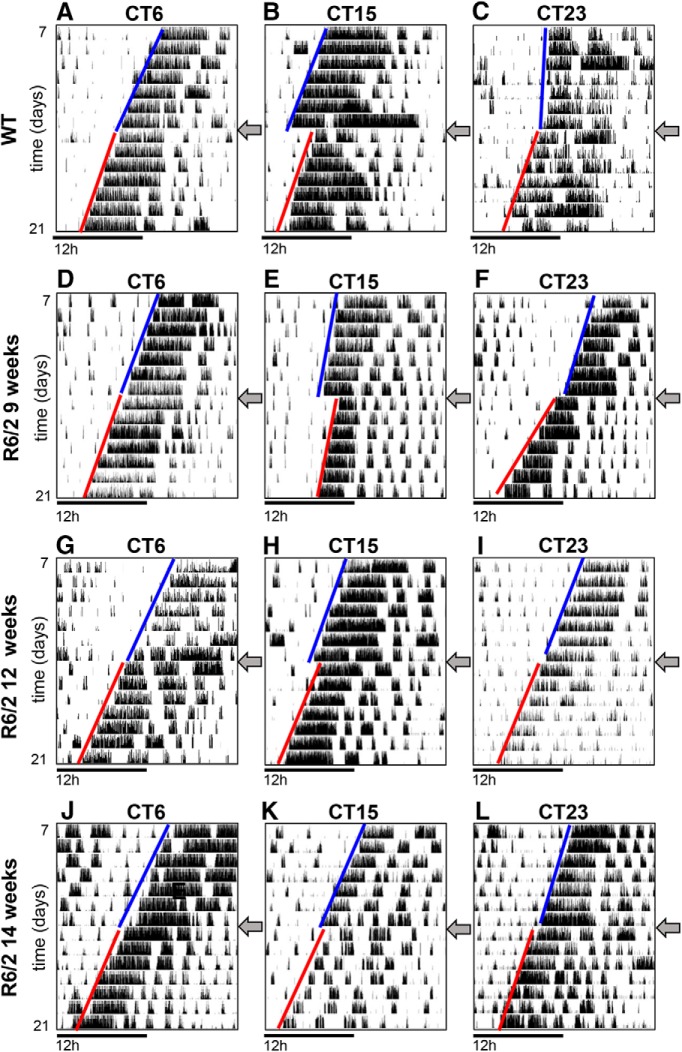
Shifts in activity onset induced by light pulses in R6/2 and WT mice. A–L, Representative single-plotted actograms of WT mice (A–C) and R6/2 mice at the age of 9 weeks (D–F), 12 weeks (G–I), and 14 weeks (J–L) placed under constant darkness and subjected to a single 15 min light pulse (300 lux) at CT6, CT15, or CT23. The arrow at the right of each actogram indicates the day when the light pulse was administered. The blue lines indicate the activity onset for 7 d before the light pulse, and the red lines indicate the activity onsets for the 7 d following the light pulse.